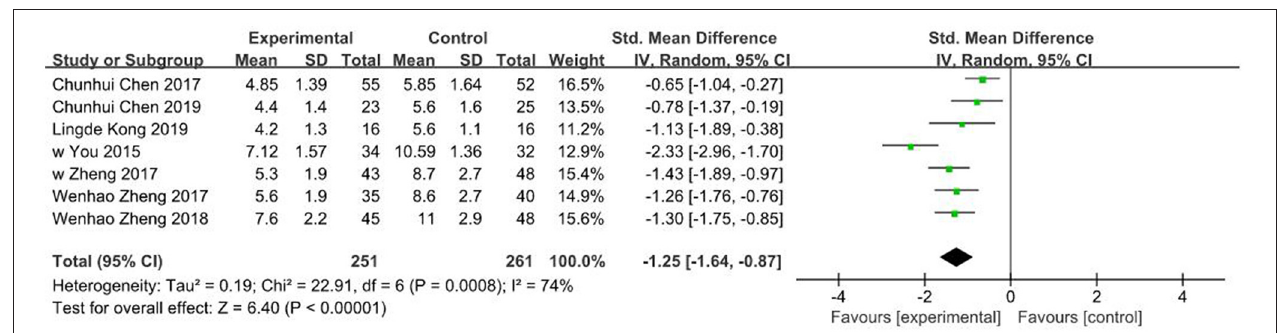
FIGURE 6 | Meta-analysis results of number of fluoroscopies.